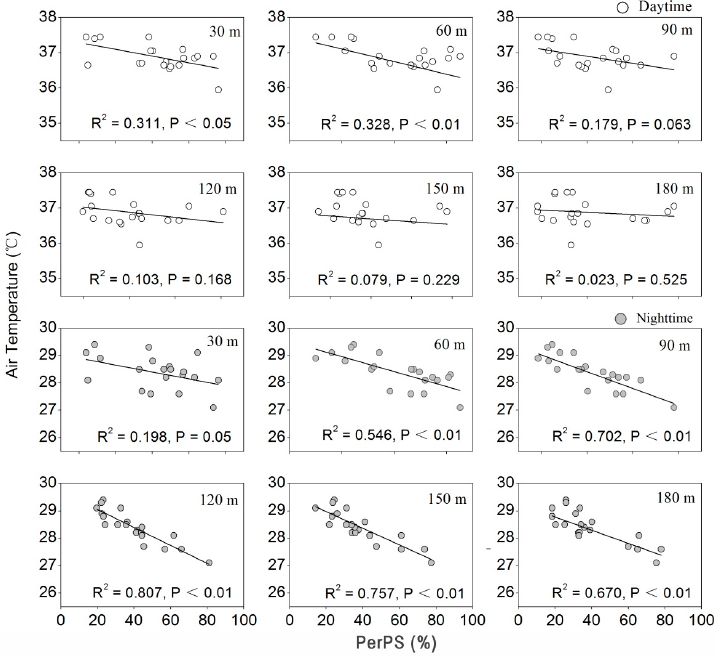
Figure 5. Relationships between air temperature and the percentage of pervious surface in different radii. Figure 6 shows the correlation of AT during two periods in a day with an impervi- ous surface fraction. During the two time periods of the day, PerIS was mainly correlated positively with AT. During the nighttime, the strongest correlation was in the 150 m ra- dius (R² = 0.587, P < 0.01), while in a radius of 60 m to 180 m, the correlations were all significant. Every 10% increase in PerIS increased the AT by 0.107 °C in the nighttime when the buffer radius was 150 m. However, the strongest correlation in the daytime was not significant even in the 60 m radius (R² = 0.121, P = 0.133).